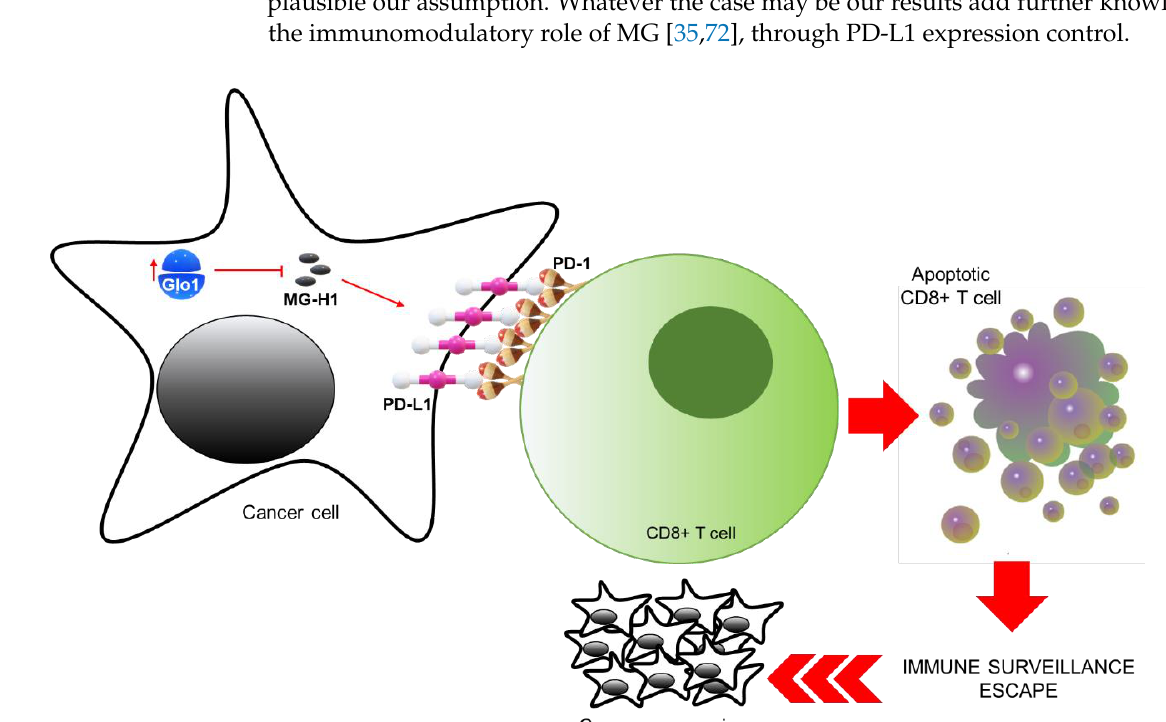
Figure 9. Glyoxalase 1-dependent methylglyoxal depletion sustains PD-L1 expression in metastatic prostate cancer cells: a novel mechanism in cancer immunosurveillance escape. Glo1, by limiting MG-H1 intracellular accumulation, prevents this specific MG-derived AGE to down-regulate PD-L1 expression in advanced metastatic cell models, all this resulting in PD-L1-mediated inhibition of cytotoxic CD8+ T cells, and consequent promotion of tumor immune evasion, with concomitant cancer progression.